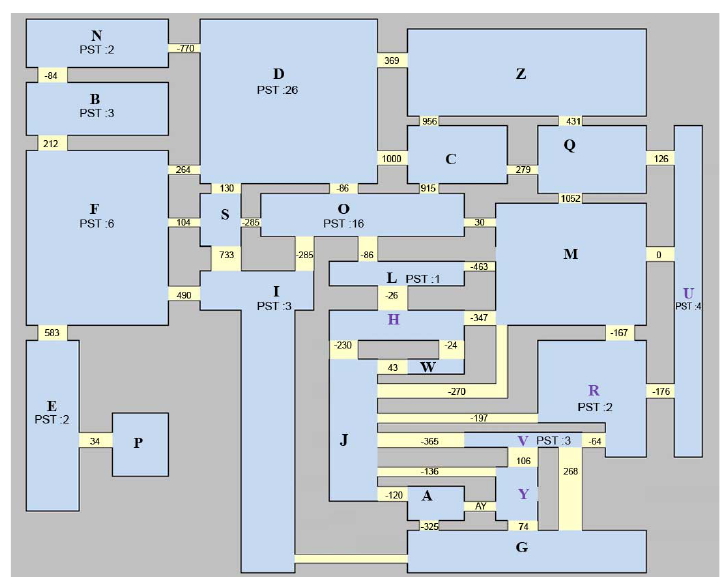
Figure 4. The partitioning of the case9241pegase.m test case in zones. This test case was taken from Fig. 2. Top view of the 9241 European system. MATPOWER . The zones D , E can be identified. From [15].